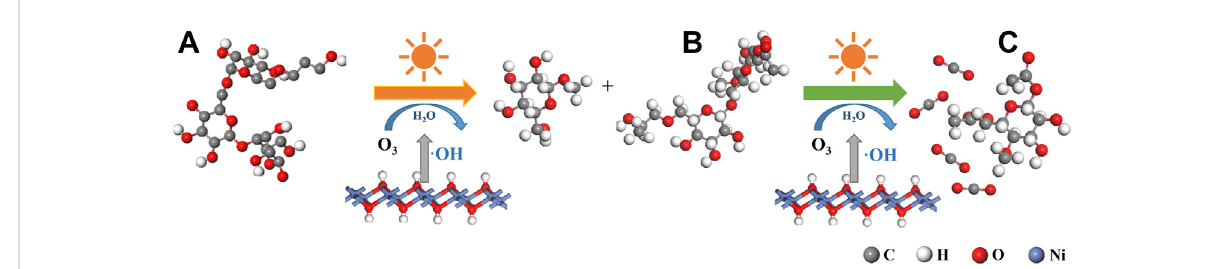
FIGURE 13 Mechanisms of ozone-synergistic α -Ni(OH) 2 photocatalytic degradation of hydroxypropyl gel breaker: (A) guanidine gum, (B) covalent intermediates, and (C) stable intermediates.